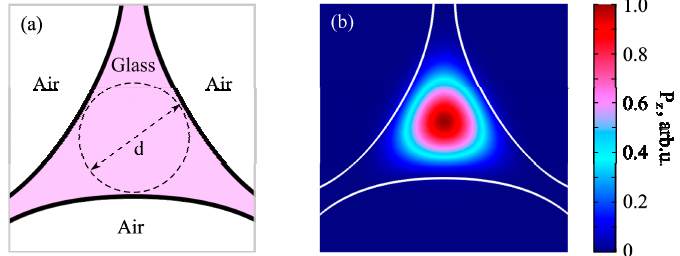
Figure 5. ( a ) Modeled cross section of MS fibers used in numerical simulation. (b) Simulated z-component of Poynting vector for d = 2 μ m at a wavelength of 2.8 μ m.